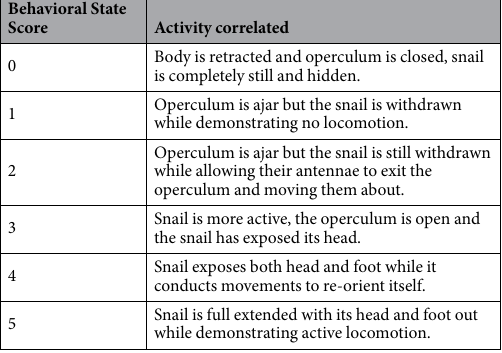
Table 2. Summary of the Behavioral State Score (BSS) criteria. The score ranges from zero to five with zero that is the least active/no movement, while five indicates the highest movement with active locomotion.